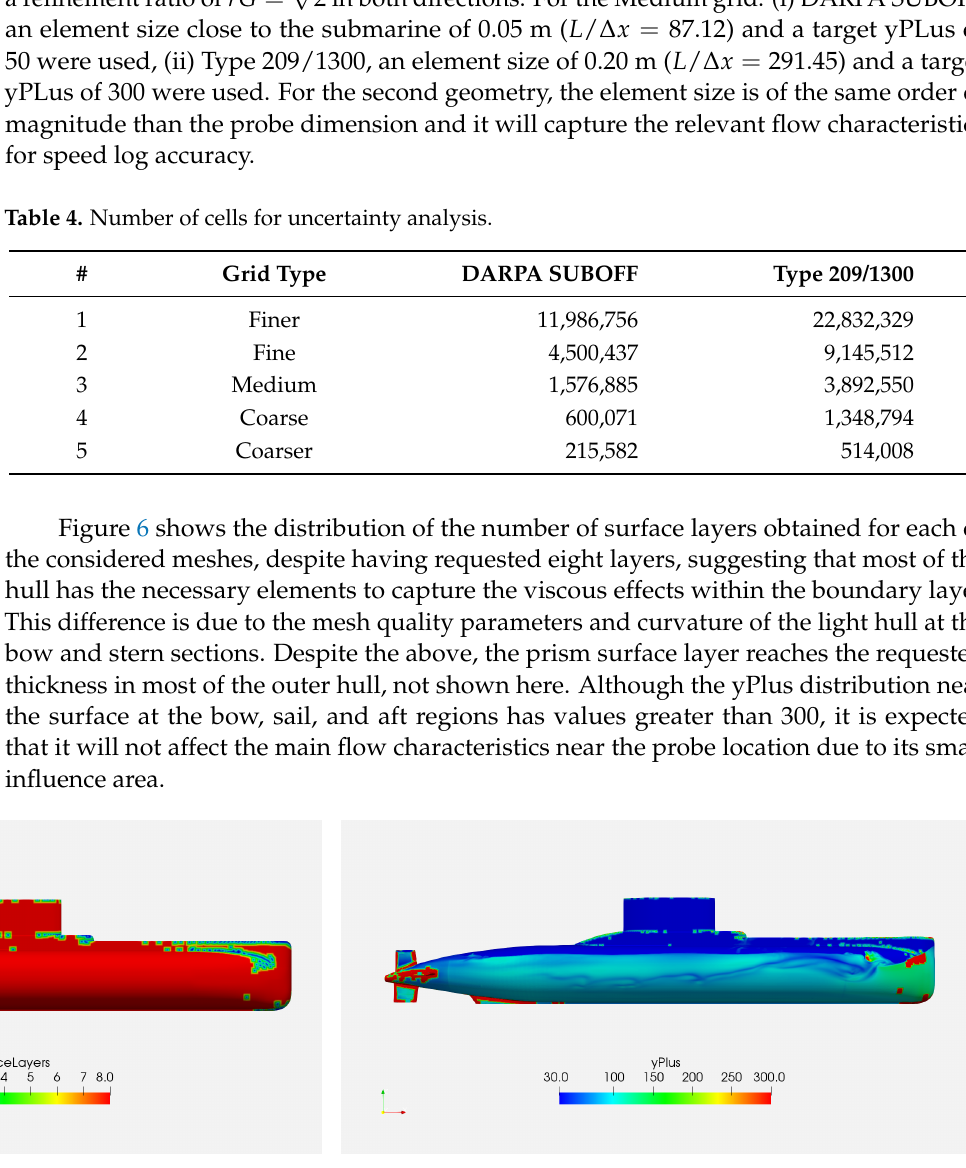
Figure 6. Actual number of surface prism layers generated around submarine by snappyHexMesh